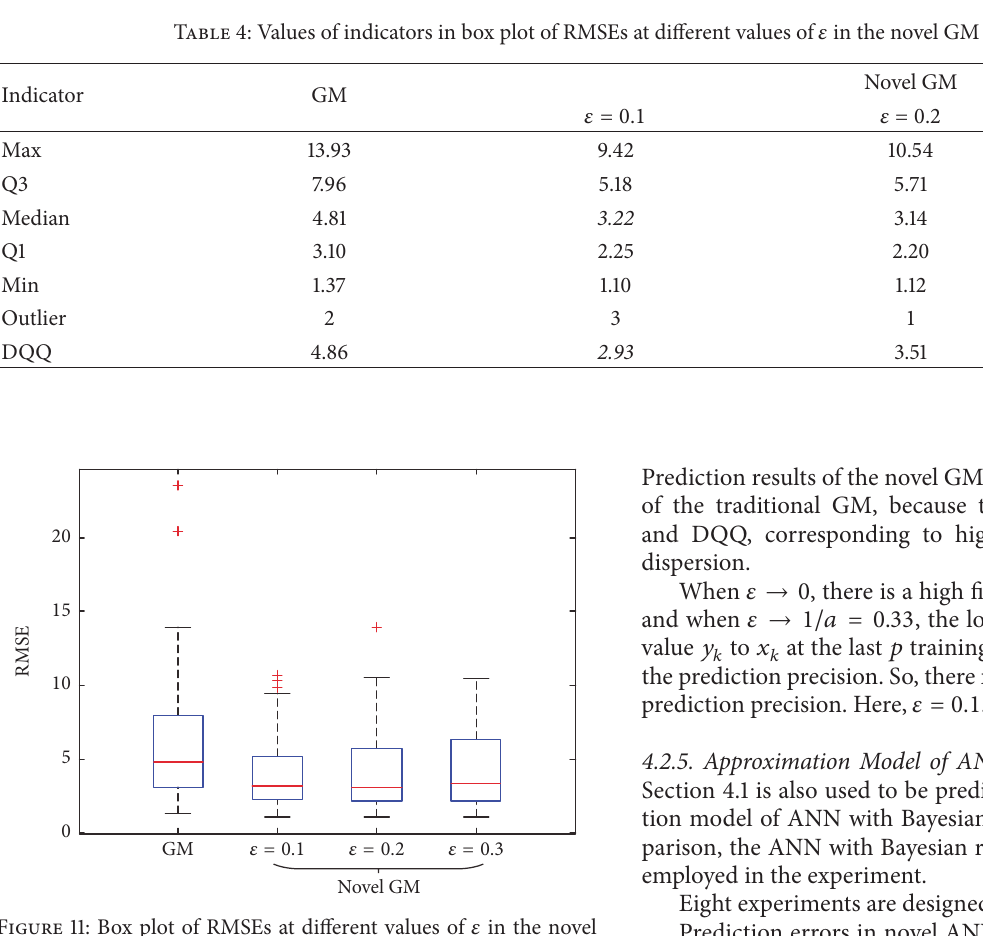
Values of indicators in box plot of RMSEs at different values of 𝜀 with the novel GM and GM are shown in Table